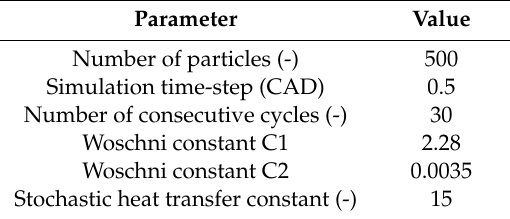
Table 4. SRM main model settings for the heavy-duty Diesel engine simulation campaign.